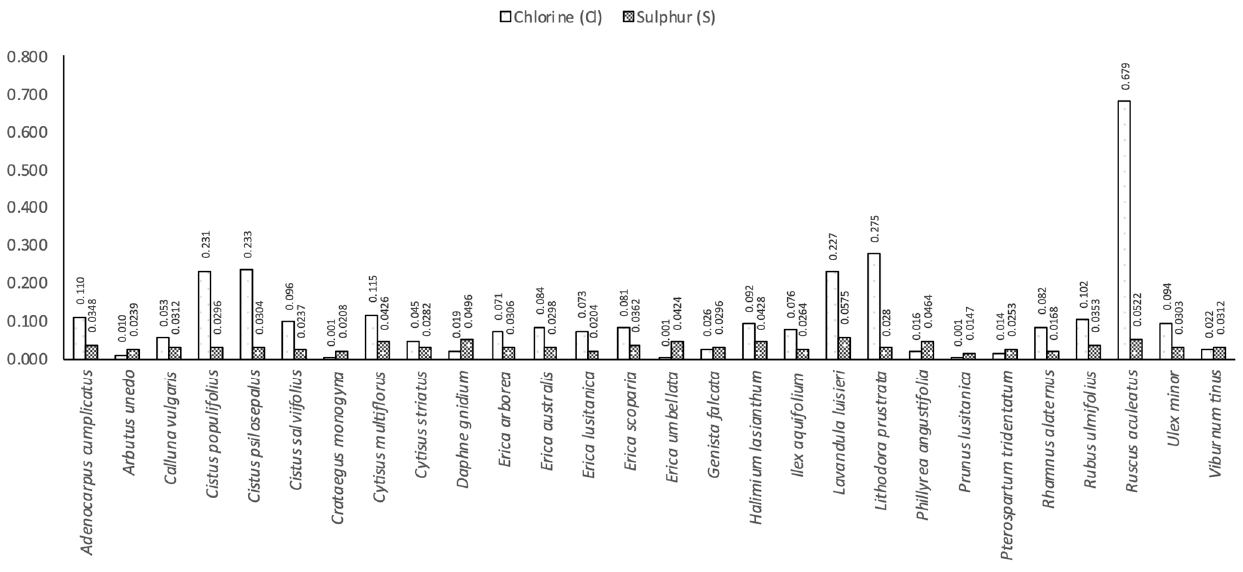
Figure 12. Chlorine and sulfur contents.